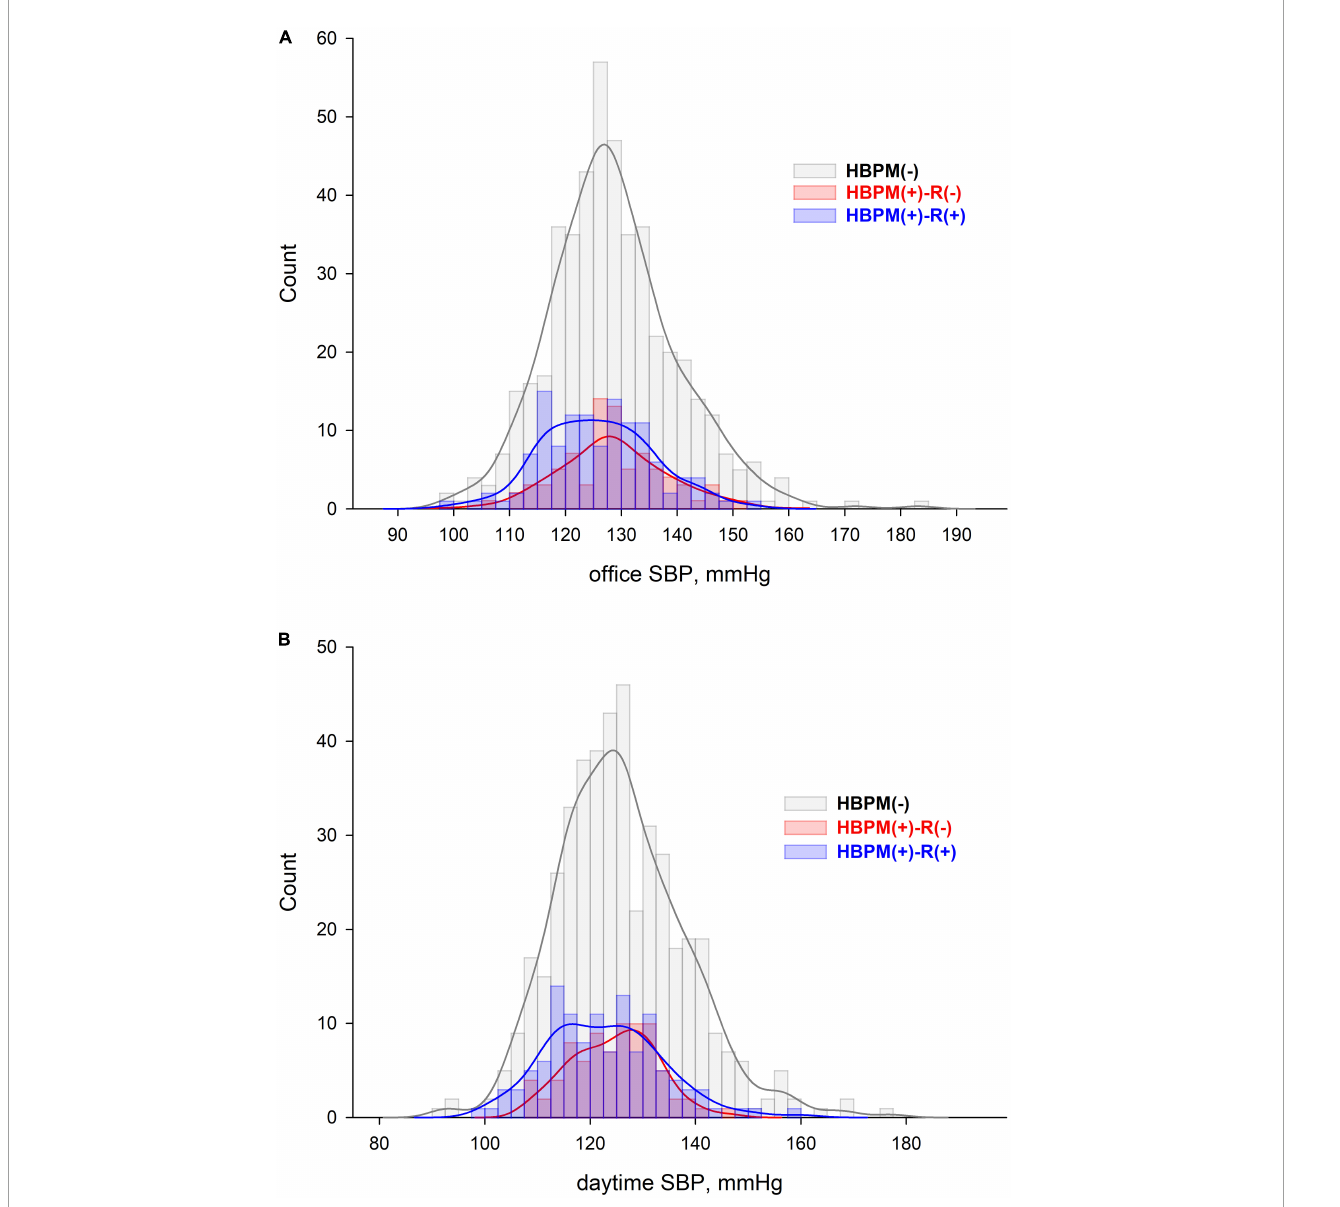
FIGURE2 Histogram and Kernel density of (A) office and (B) daytime systolic blood pressure distribution in each group.